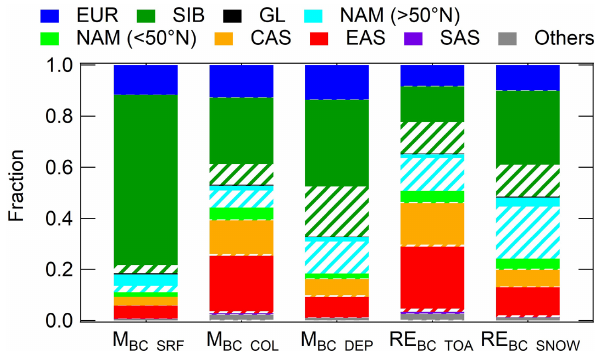
Figure 7. Source contributions to M BC_SRF , M BC_COL , M BC_DEP , RE BC_TOA , and RE BC_SNOW (from left to right) in the Arctic (annual mean). The filled and shaded areas indicate contributions from anthropogenic and biomass burning sources, respectively. EUR, SIB, GL, NAM, CAS, EAS, and SAS denote Europe, Siberia, Greenland, North America, Central Asia, East Asia, and Southeast Asia,